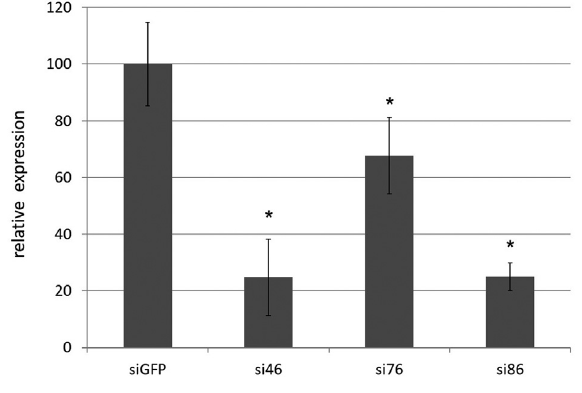
Figure 2 - PER and GP114 enzymes combat oxidative stress. Statistically significant decreases in survival percentages were observed in both treat- ments (glutathione peroxidase- and peroxiredoxin-silenced worms) ex- posed to hydrogen peroxide. (* p<0.05; t-test between control group (GFP) and corresponding experimental group).